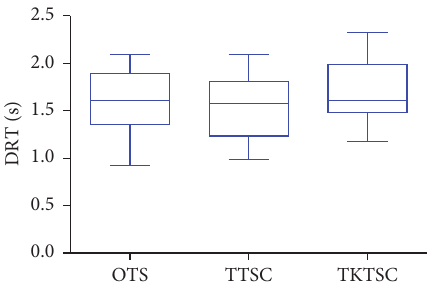
Figure 8: The descriptive statistics of DRT in